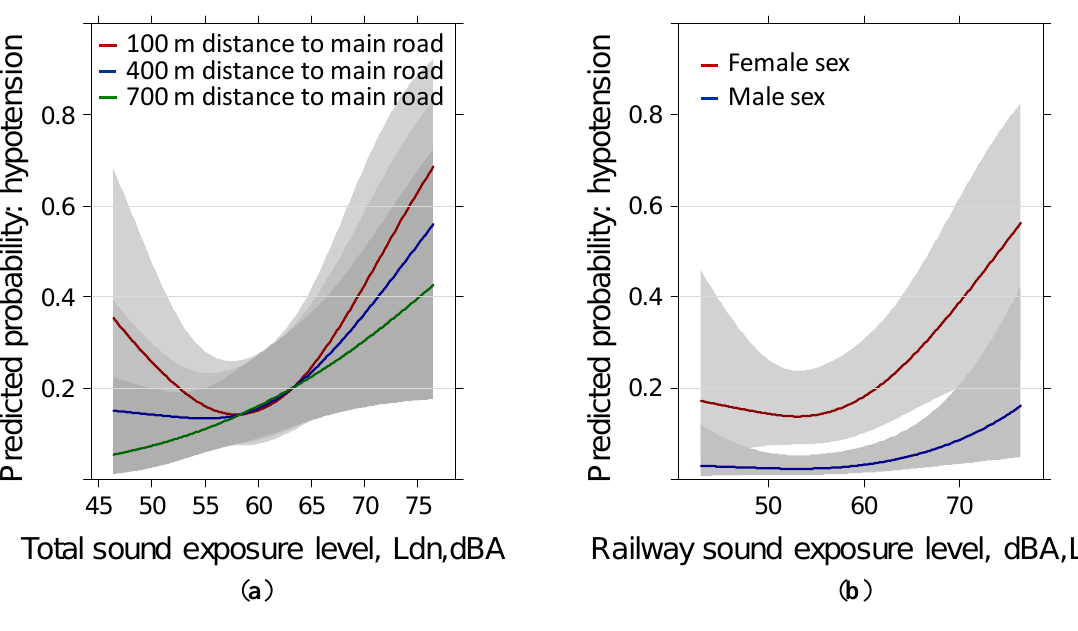
Figure 2. Predicted probability of reported hypotension past year with total sound exposure moderated by: ( a ) distance to the main road and ( b ) railway sound exposure by sex. Models are adjusted for age, education, anti-hypertensive treatment, family history of hypertension, weather sensitivity, health status, sleep score, distance to main road, annoyance by local roads, region and the IA-terms age × sex, weather sensitivity × health, weather sensitivity × sound exposure, distance × sound exposure, and annoyance × sound